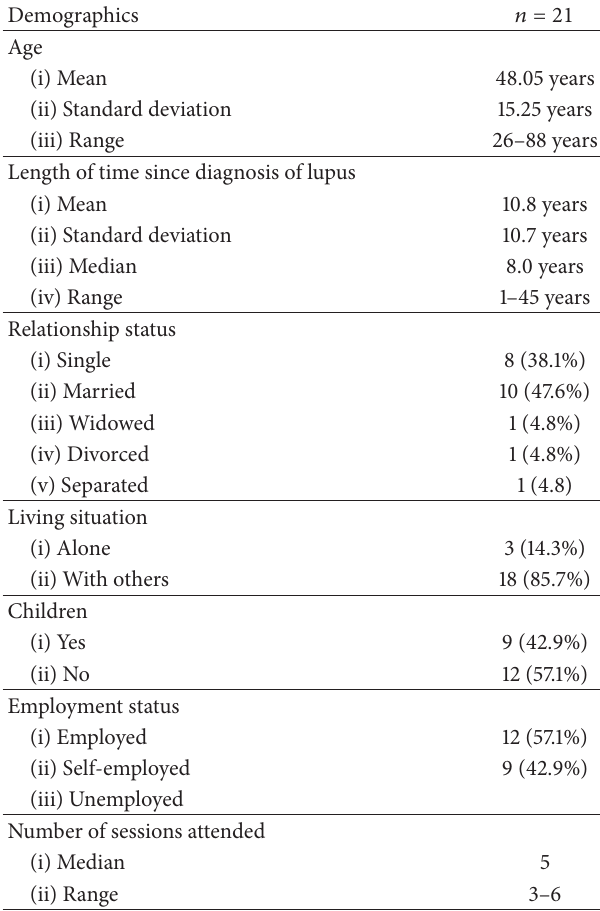
Table 1: Participant